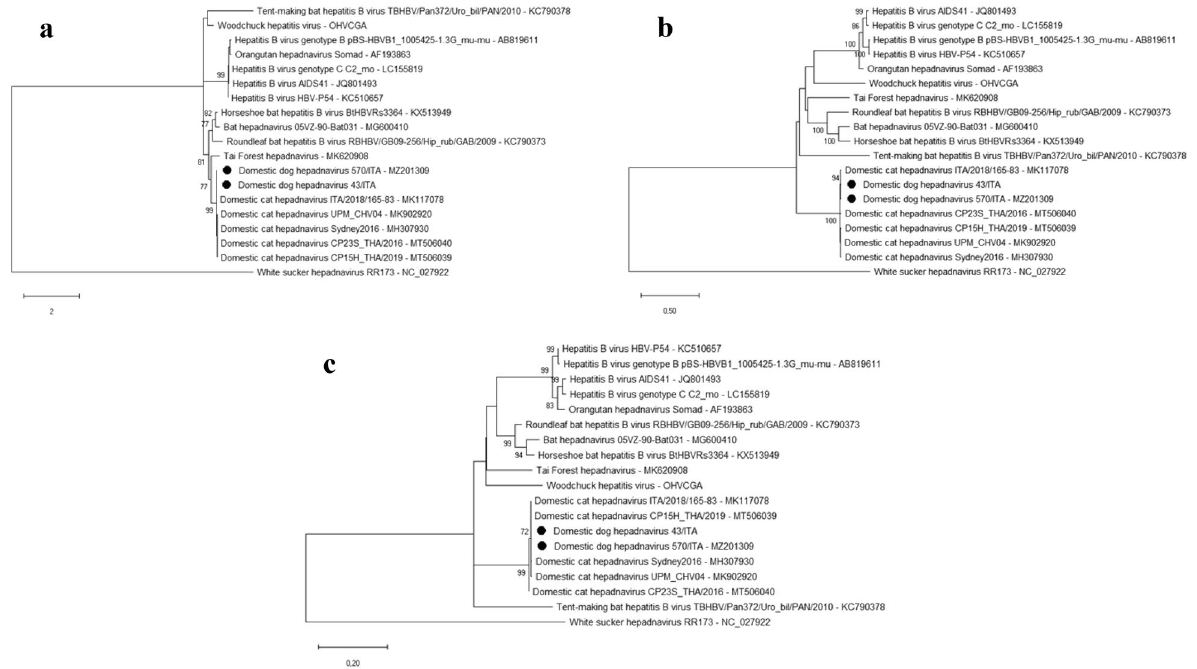
Figure 2. Phylogenetic trees based on three different gene targets, ( a ) core (partial-length), ( b ) polymerase (partial-length) and ( c ) surface (full-length), of hepadnaviruses retrieved from the GenBank database. GenBank accession numbers are provided for reference strains. The trees were generated using the maximum likelihood method, Hasegawa-Kishino-Yano model with a gamma distribution and invariant sites, and bootstrapping up to 1000 replicates. Bootstrap values > 70% are shown. Italian DDH strains 43/ITA and 570/ITA (GenBank accession no. MZ201309) are indicated by black bullets. White Sucker hepadnavirus (NC_027922) was used as outgroup. Scale bar indicates nt substitutions per